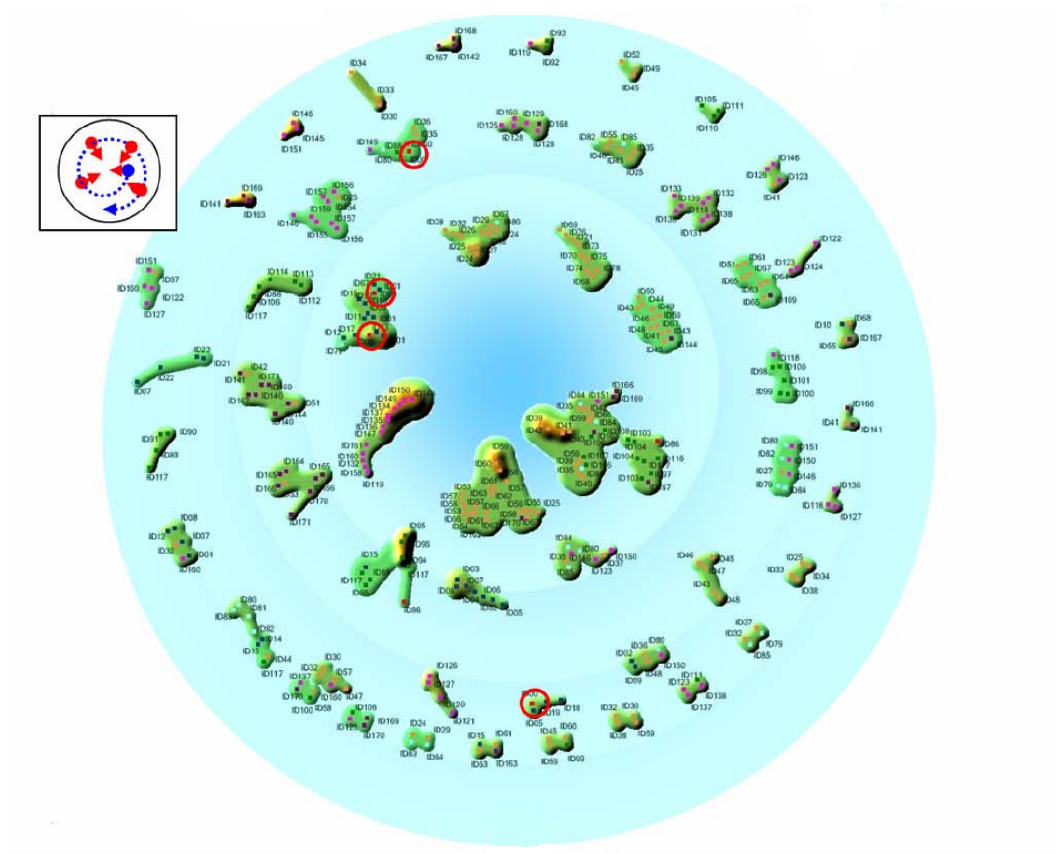
Figure 3. The dendrographic representation of the hierarchical relationship. The higher up the member is, the closer to the centre their node is drawn. Clusters of users are highlighted in green. The dots represent individuals and are also given unique identification numbers. The dots are coloured by the role classification of the employee and the definition of the contours around the dots within each group highlight how well the group integrates. Image courtesy of Otsuka et al.